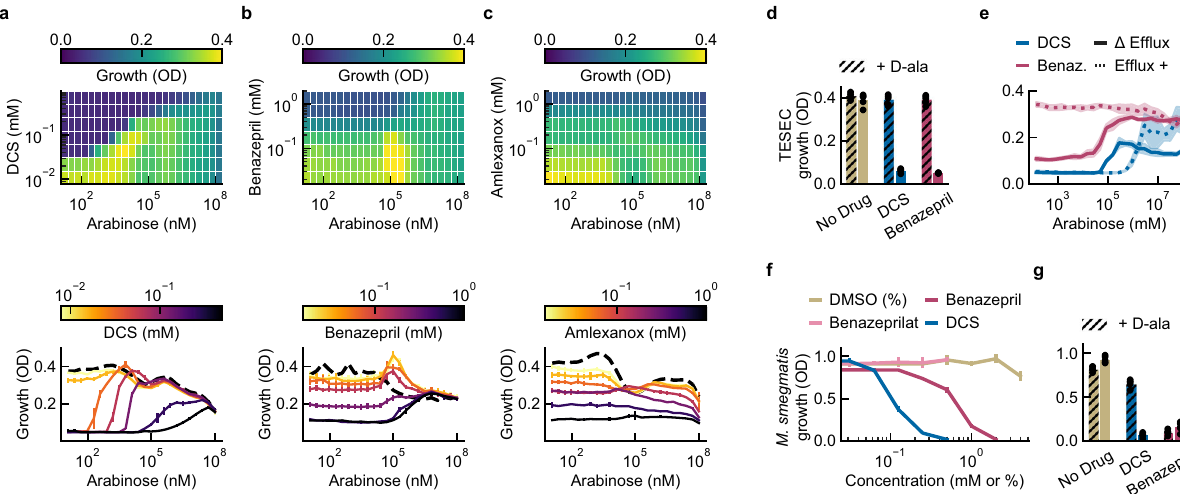
Fig. 4 Characterization of hits with TESEC chemical-genetic pro fi ling and in M. smegmatis . a – c The TESEC Mtb Alr expression strain was induced at a range of arabinose concentration and exposed to the indicated drugs at a range of concentrations, producing a two-dimensional growth pro fi le for each drug. Heatmaps of growth under DCS and benazepril treatment revealed a characteristic interaction between drug activity and target expression, appearing as a diagonal line. Amlexanox did not show this interaction. Detailed dose-response pro fi les were qualitatively different for each drug. Data are presented as the man and CI 95 for three biological replicates. d Supplementation of TESEC Mtb Alr with 5 mM D-alanine, the enzymatic product of Alr, eliminated the inhibitory activity of both 0.25 mM DCS and 1 mM benazepril. Data are presented as the mean and Individual data points for fi ve biological replicates. e Restoring the activity of the TolC ef fl ux system eliminated the inhibitory effect of 0.5 mM benazepril, but not of 0.1 mM DCS. Lines represent the mean and shaded areas the CI 95 of six biological replicates. f M. smegmatis growth was inhibited by benazepril and DCS, but not benazeprilat or DMSO-only controls, in the millimolar range. Data are presented as the mean and CI 95 of fi ve biological replicates. g Supplementation with 5 mM D-alanine rescued growth of M. smegmatis treated with 0.25 mM DCS, but not cells treated with 1 mM benazepril. Data is presented as the mean and individual data points for fi ve biological replicates. Source data are provided as a Source Data fi le. Table 1 Antibiotic activity of benazepril against Mtb . M. indicated